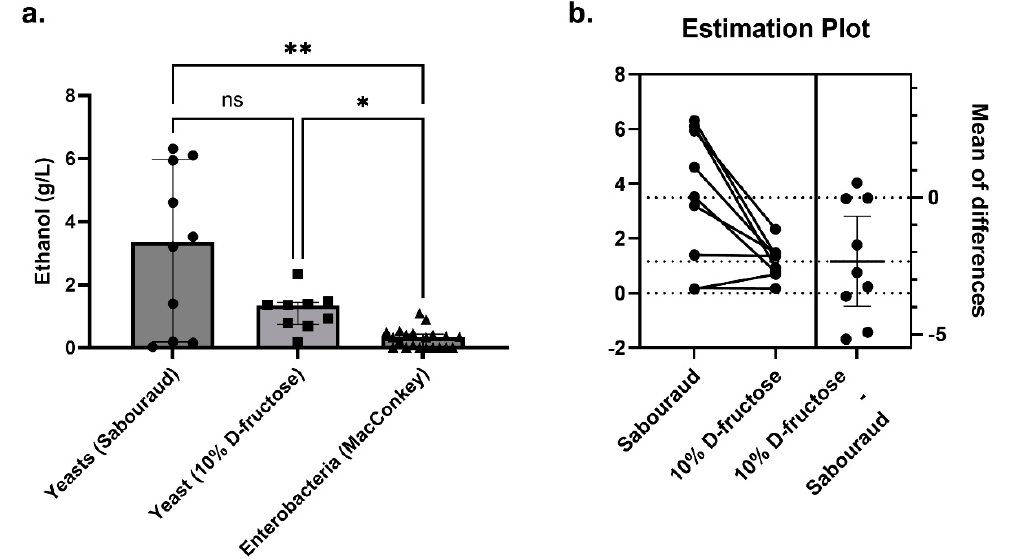
Figure 5. Ethanol production by yeast compared to enterobacteria isolated from NASH patients. ( a ) In Sabouraud’s medium ( n = 10 yeast strains), the concentration of ethanol produced by yeast was 10-fold higher than that produced by enterobacteria (MacConkey’s medium, n = 21 bacterial strains), including Klebsiella pneumoniae , which produces a lot of alcohol (HiAlc Kpn, 1.09 g/L for the strain with maximum ethanol production). In a secondary analysis using 10% D-fructose restricted medium ( n = 9 yeast strains, Galactomyces_geotrichum_N9 was lost before this secondary experiment), substantial ethanol production was observed. * p < 0.05, ** p < 0.005. ( b ) For the nine strains for which ethanol production could be assessed on both Sabouraud’s and 10% D-fructose, ethanol production was significantly higher on Sabouraud’s medium (paired two-tailed t -test, p = 0.015).